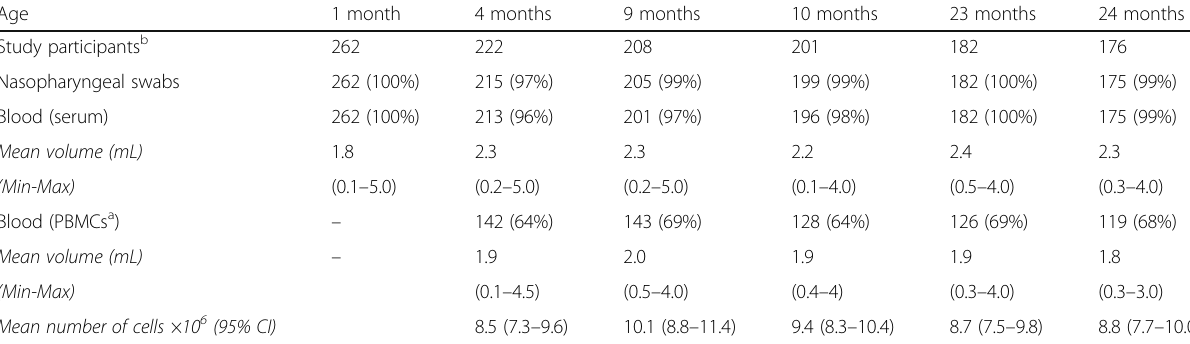
Table 3 Number of collected specimens (% of participants seen at specified age), blood volumes and PBMCs a isolated at study